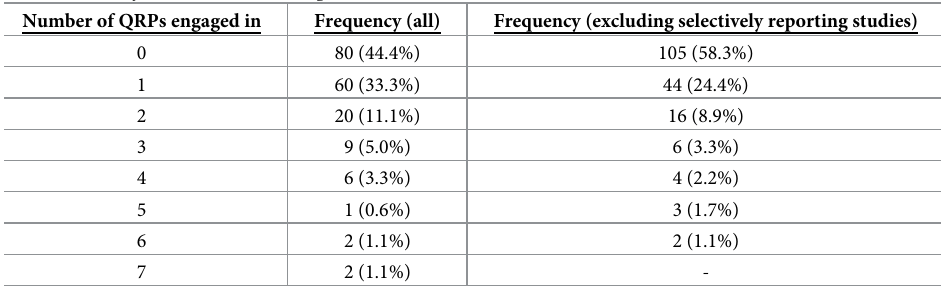
working lifetime (see Table B in S2 Table for a direct comparison of prevalence estimates from both of these studies). Comparing our results to Fiedler & Schwarz’ estimated prevalence rates of individual QRPs, most QRPs have similar self-reported prevalences, but rounding off p val- ues and deciding whether to exclude data post-analysis are noticeably more common in our sample ( Δ cf > 5%), while selectively reporting studies that “worked” is much more common ( Δ cf > 15%). It is unclear whether these differences are due to random sampling error, mea- surement error in Fiedler & Schwarz’ estimation of prevalence or to a systematic difference between our sample of German students and their sample of German researchers, but they apparently do not support the conclusion that students are employing fewer QRPs than